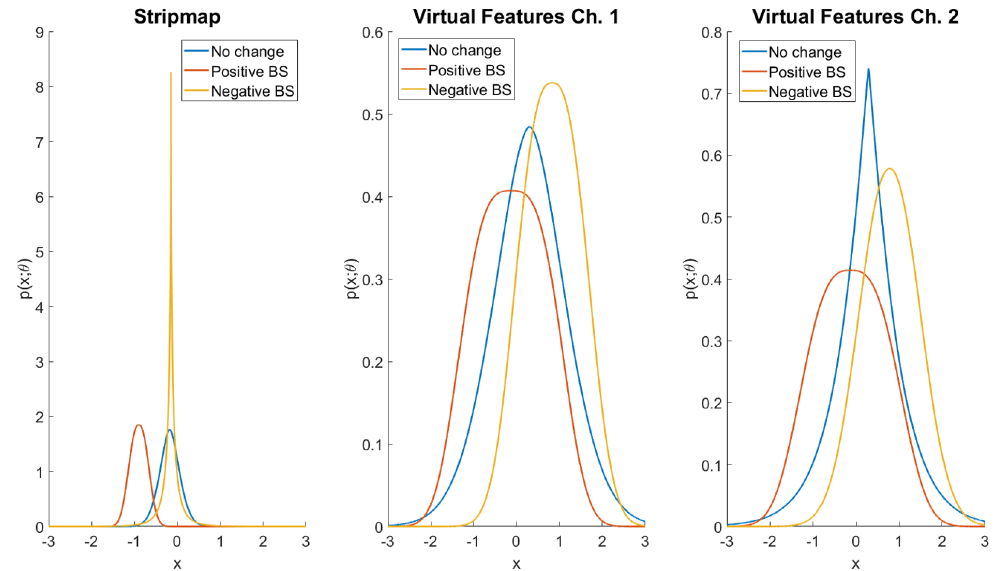
Figure 12. Conditional PDFs estimated by the proposed method and related to the “no-change” class and to the “change” classes associated with positive and negative variations in the backscattering coefficient. From left to right: class-conditional densities of the stripmap log-ratio and of the first and second virtual features associated with the two polarimetric